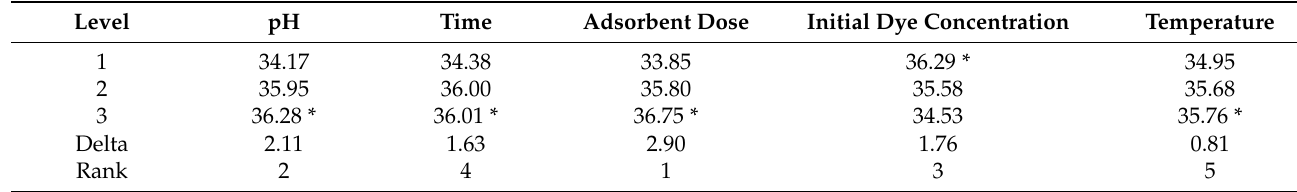
Table 3. Signal-to-noise S/N ratios